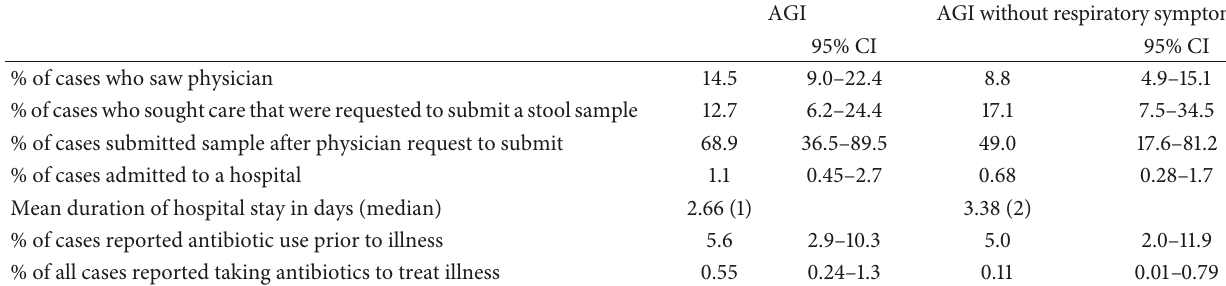
Table 5: Health care seeking, stool submission, and medication use of acute gastrointestinal illness cases in Canada, 2014-2015.